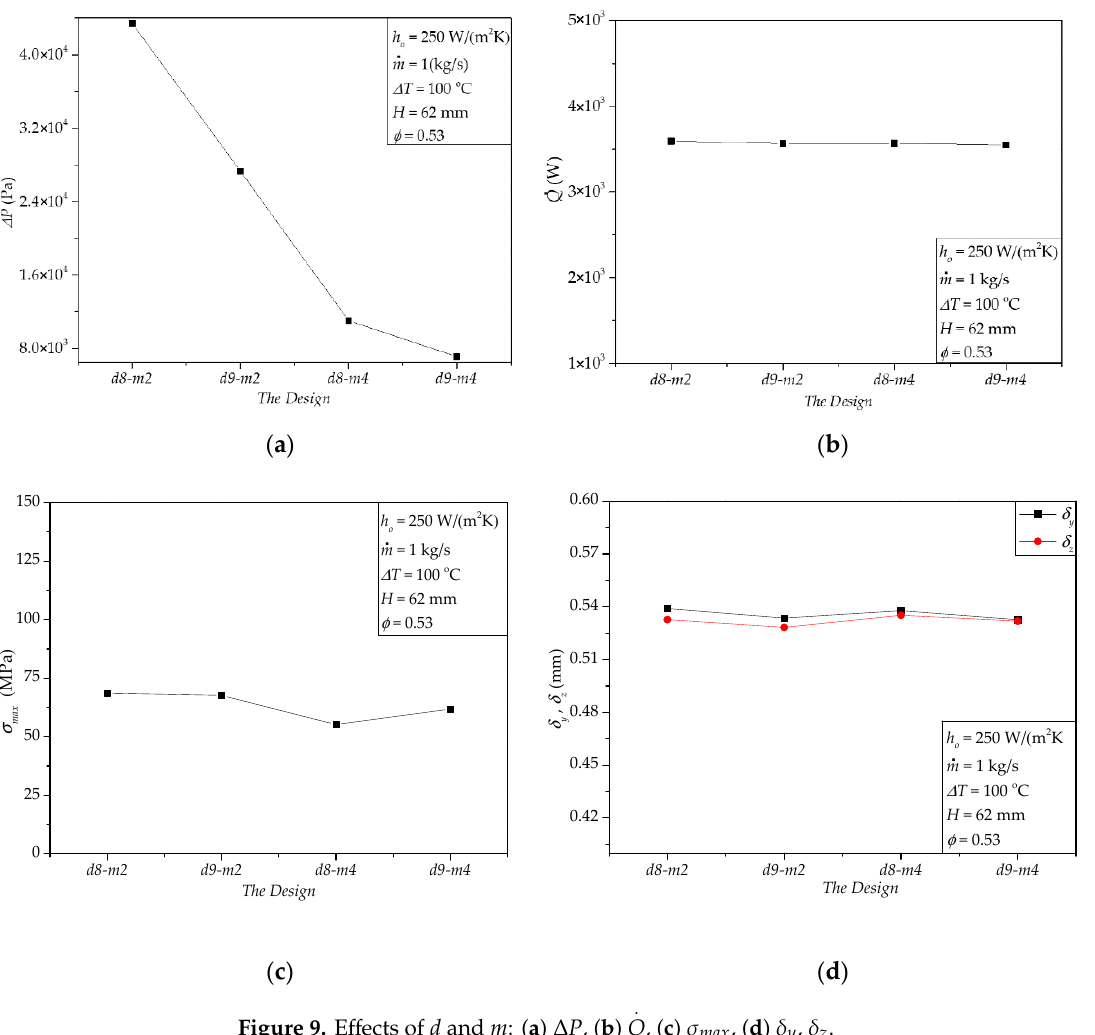
Figure 9. E ff ects of d and m : ( a ) ∆ P , ( b ) Figure 9. Effects of d and m : ( a ) Δ P , ( b )